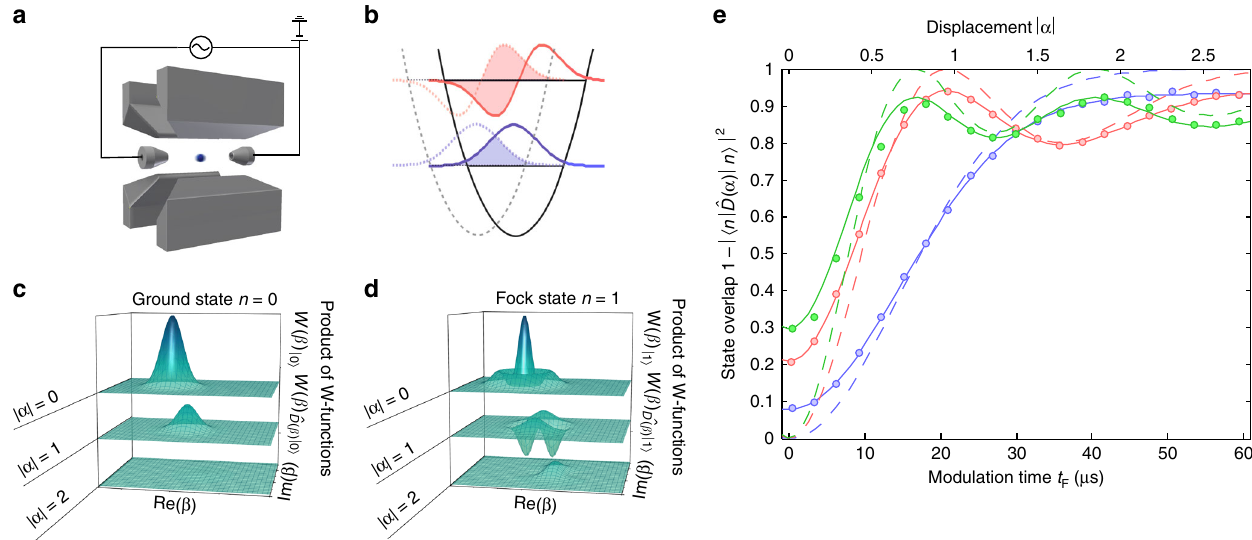
Fig. 1 Measuring displacement amplitudes. a Schematic of the experimental setup: a magnesium ion is trapped in a linear Paul trap and an additional ac voltage on the end electrodes implements the motional displacement (coherent excitation of motion). b Illustration of the wave function overlap. Initial motional state wave functions are shown as dashed lines ( n = 0 blue, n = 1 red). After applying a resonant oscillating force, the ion ’ s motion is in a displaced Fock state whose wave function is depicted by the solid colored lines. To infer the displacement, the wave function overlap is measured as sketched by the colored areas. c, d Illustration of the mechanism behind enhanced sensitivity of Fock states to displacements. c and d show the theoretically calculated product of the initial and fi nal Wigner function for three different displacements for the Fock states n = 1 and n = 0, respectively. By integrating over the whole phase space it is possible to infer the state overlap shown in e . The negative parts of the n = 1 Fock states lead to a vanishing integral for α = 1, before the contours of the Wigner functions are fully separated. For states without negative regions in the Wigner function, such as Gaussian states, the integral can only vanish when the product of Wigner functions vanishes over the whole phase space. e The graph shows the outcome of the state overlap measurement for three different initial Fock states (blue: n = 0, red: n = 1, green: n = 2). The oscillating force is applied for different duration t F . The solid curves are fi ts of the equation given in the main text to the data and the dashed lines are the corresponding theoretical curves assuming full contrast. The fi t for the motional ground state is used to calibrate the upper x -axis, denoting the displacement amplitude | α |. Error bars for the standard error of the mean (s.e.m.) due to quantum projection noise are too small to be seen. Each point is an average of approximately 10000 ( n = 0) or 3000 ( n = 1, n = 2) experiments